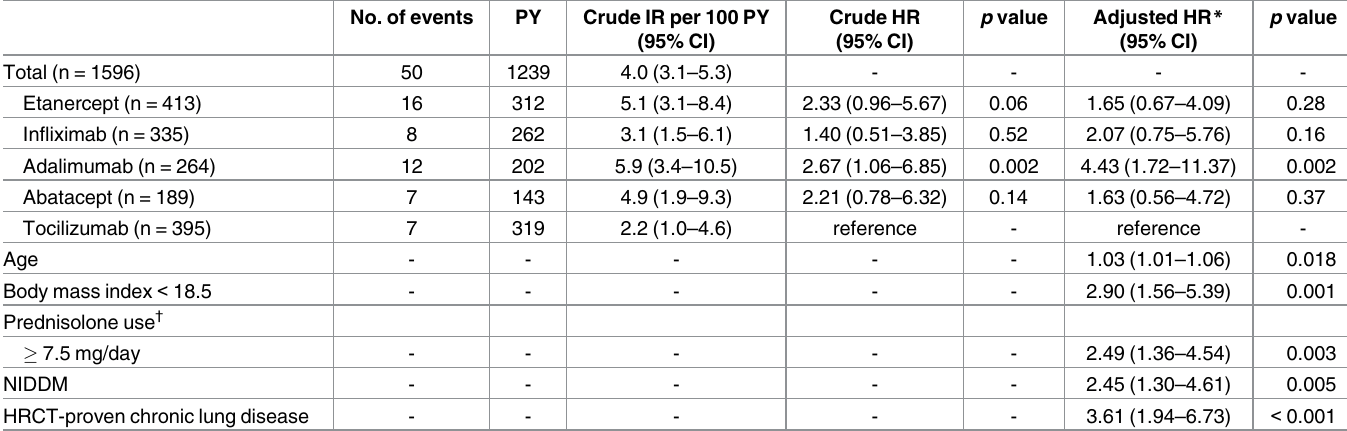
Table 4. Comparison of the risk of pulmonary hospitalized infection during the first year of follow-up between treatment groups of RA